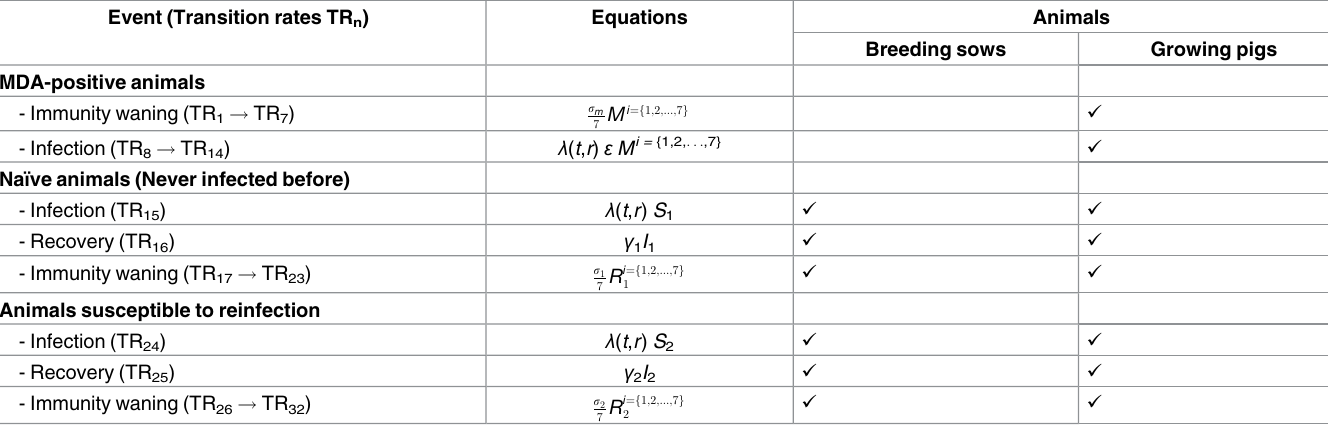
λ ( t , r ) is the global force of infection at time t in batch b , γ 1 is the recovery rate for infected animals I 1 , σ 1 denotes the immunity waning after a swIAV infection, σ m is the maternal immunity waning. These rates are applied to their relative state variables representing the evolution of the individualsthroughout the epidemic process (Fig